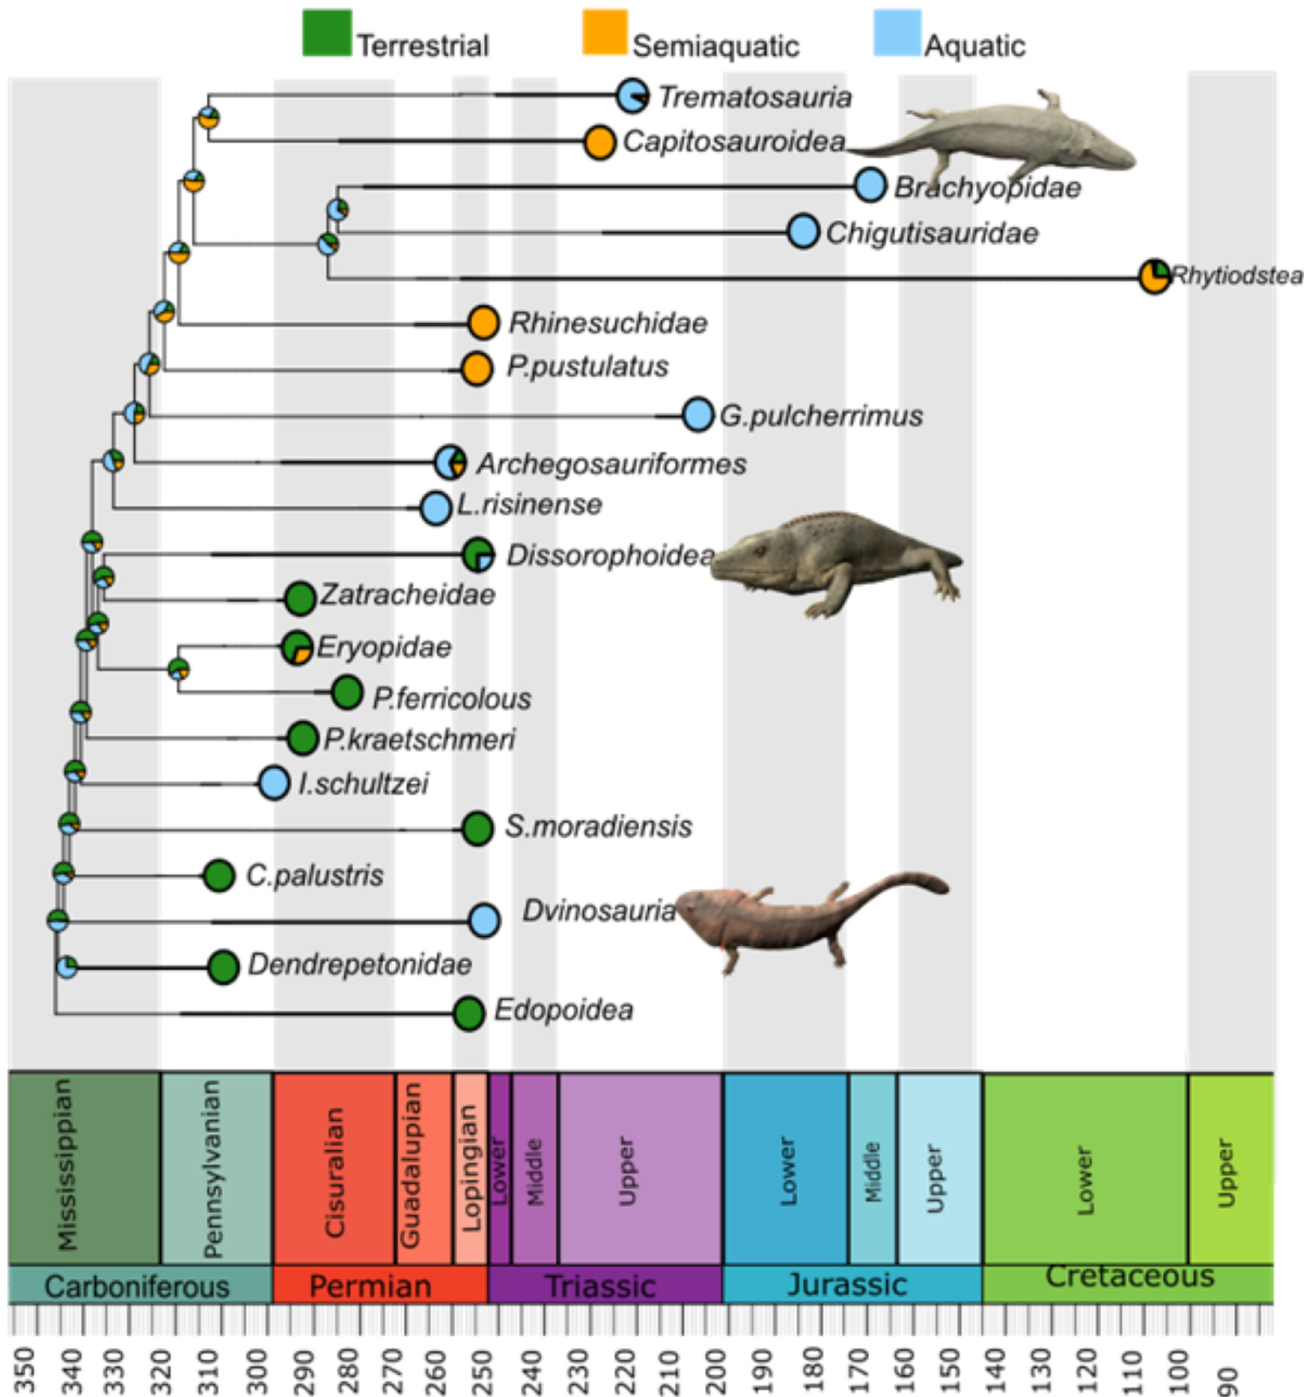
Fig 4. Phylogeny and habitat of temnospondyls. Tip colors are pooled prior probabilities for clades as gathered from literature and paleobiology database (PBDB; Supplementary Information). Node colors display posterior probabilities calculated from the best-fit (OU; terrestrial-semiaquatic-aquatic) mode in Ancthresh. Thick lines represent stratigraphic range. Reconstructions borrowed with permission from Nobu Tamura.